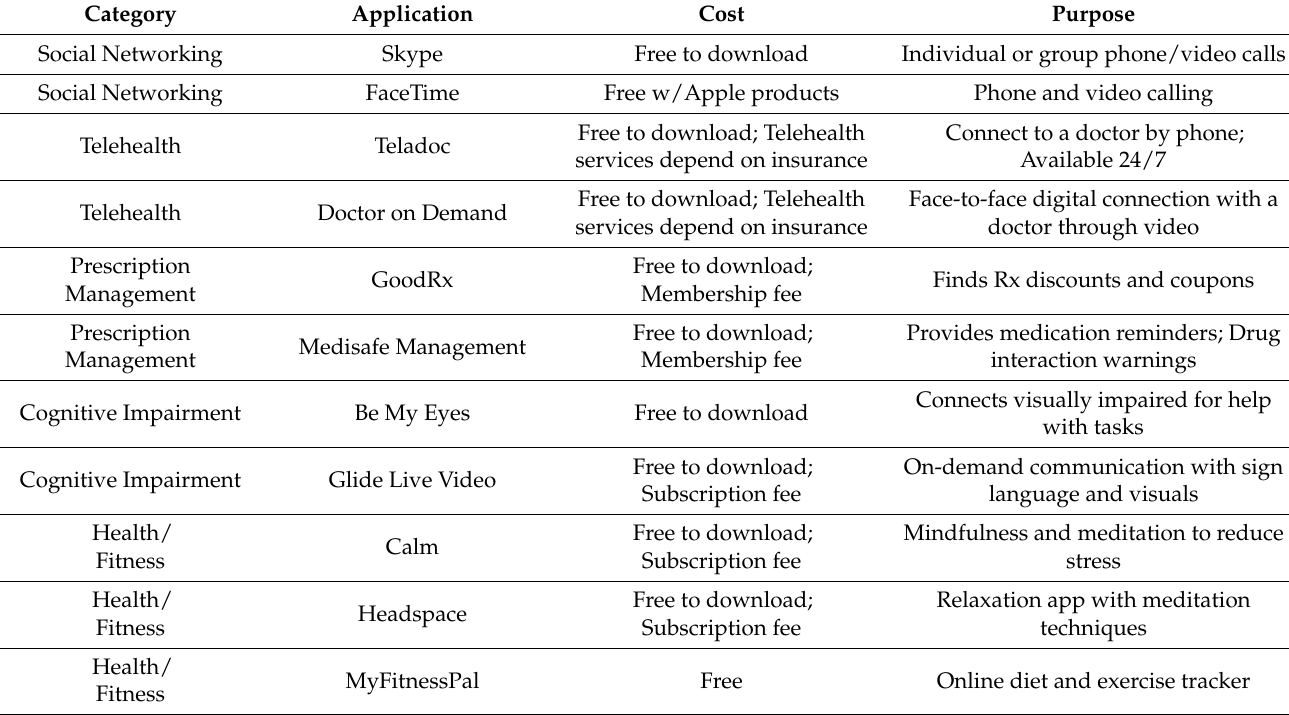
Table 2. Applications to Support Socially Isolated Older